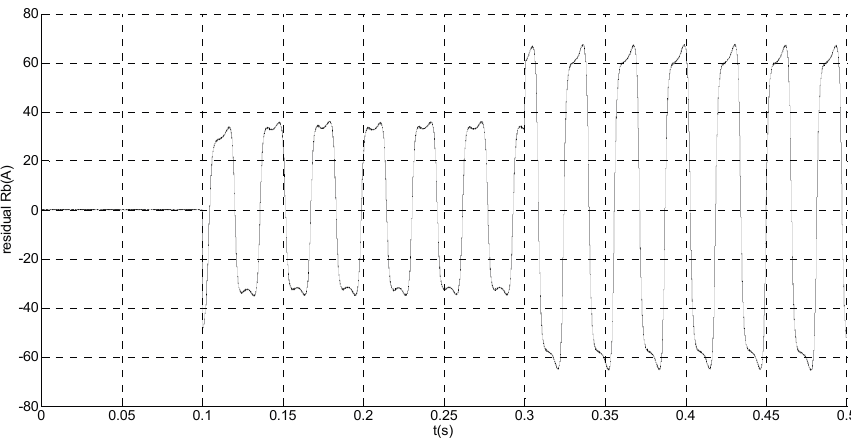
Figure 14. Simulation result of current residual in phase ‘a’.